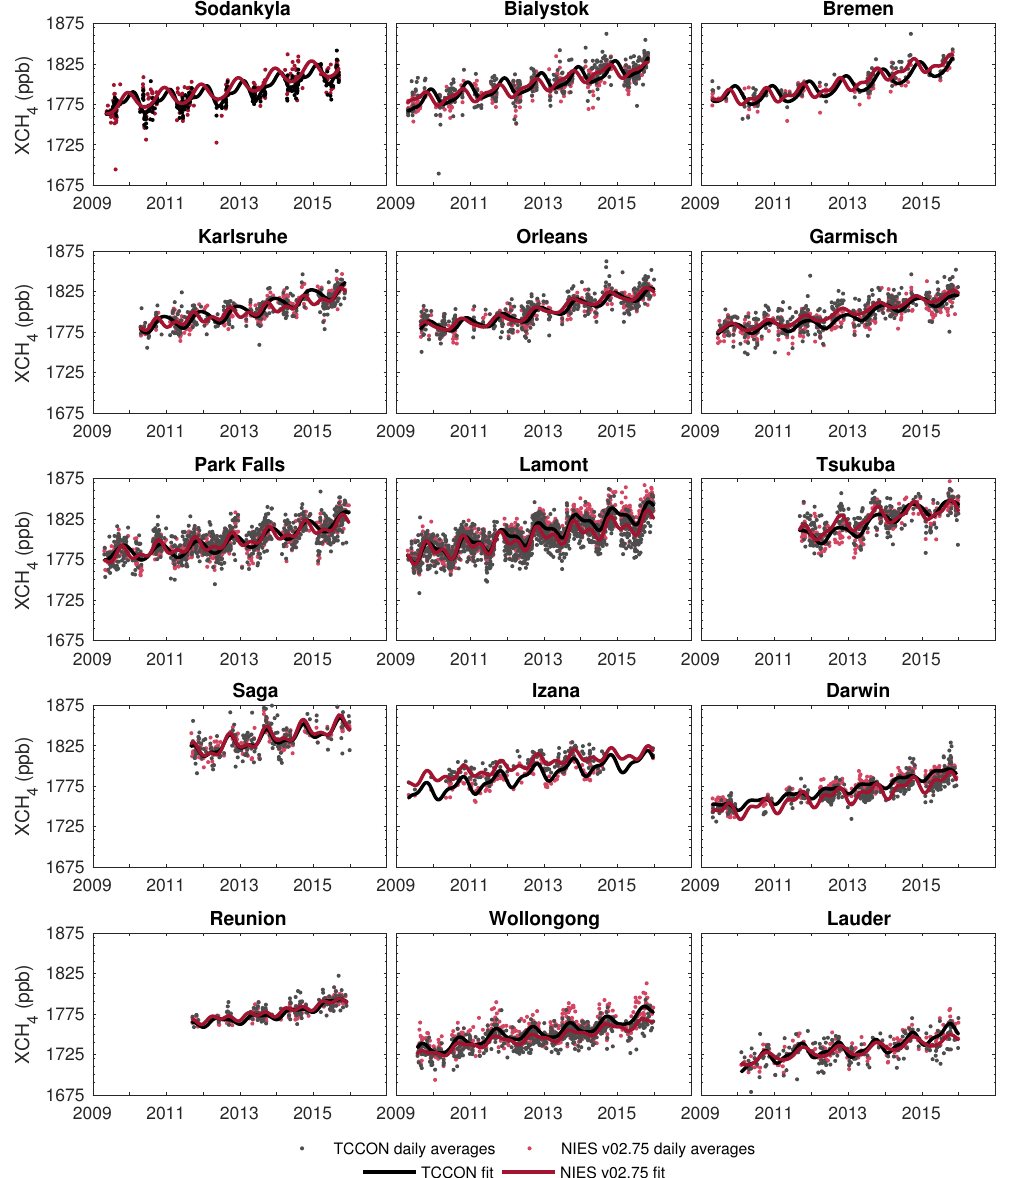
Figure A1. Daily averages and DLM fits of XCH 4 for NIES v02.75 retrieval algorithm at the TCCON sites. The sites are arranged by their latitude from the northernmost (Sodankylä) to the southernmost